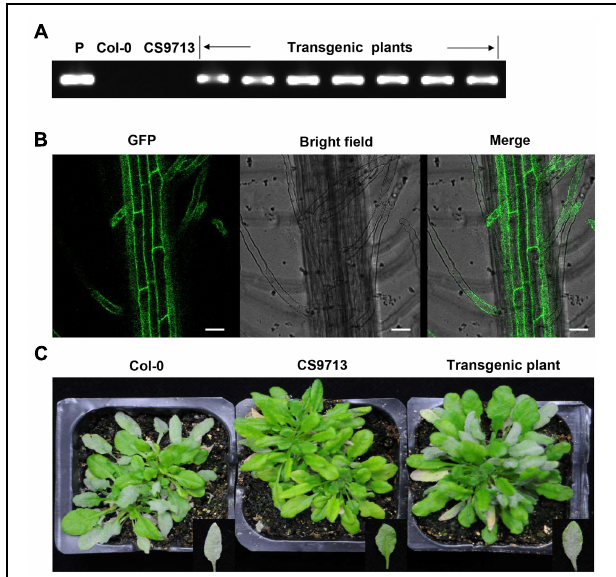
FIGURE 4 | Complementation test of CsMLO1 in Arabidopsis . (A) PCR results for the recombinant plasmid, the Col-0 wild type, the Atmlo2 Atmlo12 double mutant CS9713 and the transgenic plants. (B) GFP fluorescence in the roots of the transgenic plants in the Arabidopsis CS9713 genetic background. Scale bars = 30 µ m. (C) Infection phenotype of the Col-0 wild type, the Atmlo2 Atmlo12 double mutant CS9713 and the transgenic plants at 12 days post-inoculation.